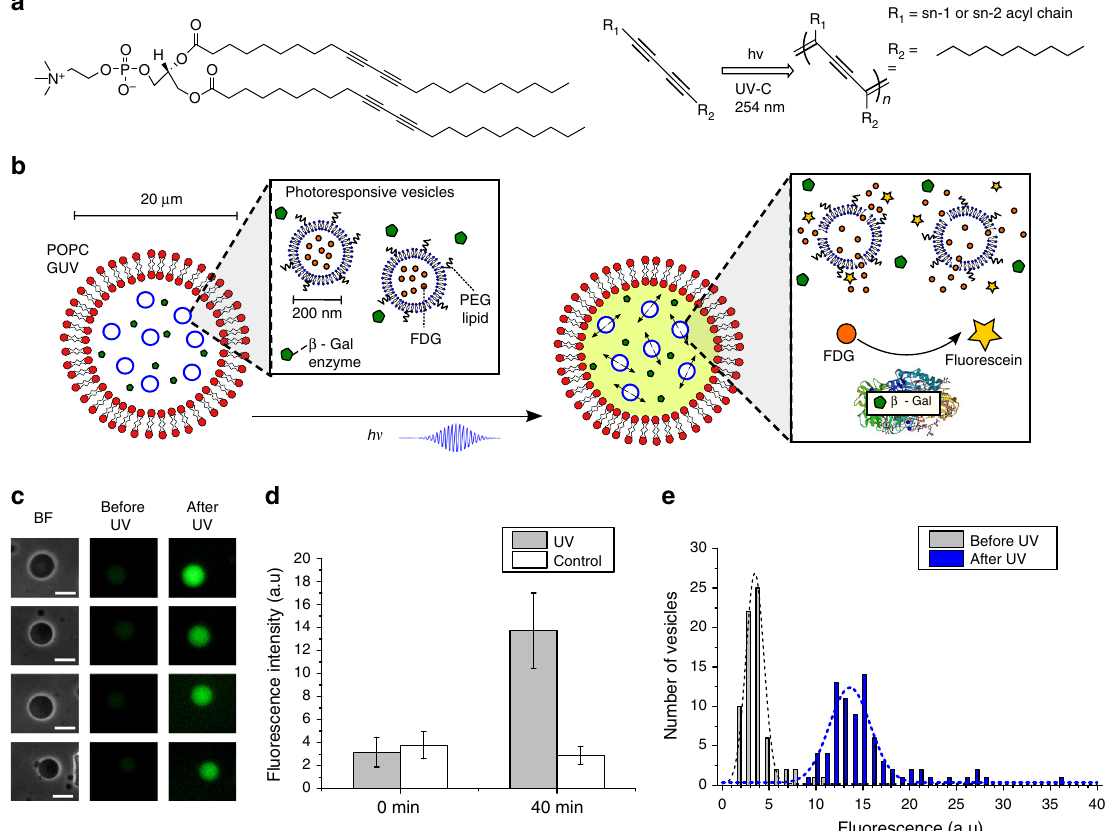
Fig. 1 UV-responsive nested vesicles can be created via phase-transfer. a Chemical structure of DC 89 PC and the UV-catalysed polymerisation of diacetylene molecules. b Cartoon of UV-responsive nested vesicle mechanism. Photo-responsive vesicles and the enzyme β -galactosidase are co- encapsulated within POPC GUVs created via phase-transfer. Upon illumination with UV-C, photopolymerisation of the inner compartment membranes results in FDG release, leading to its catalysis by β -galactosidase forming free fl uorescein. c Optical microscopy of UV-responsive vesicles before UV irradiation and 30 min after UV irradiation. Scale bar in all images, 25 μ m. d Comparison of mean fl uorescence of UV-responsive nested vesicles before and after 10 min irradiation and 30 min wait. Controls are left for 40 min without application of UV. Error bars represent 1 s.d. ( n = 71/79 for before/after